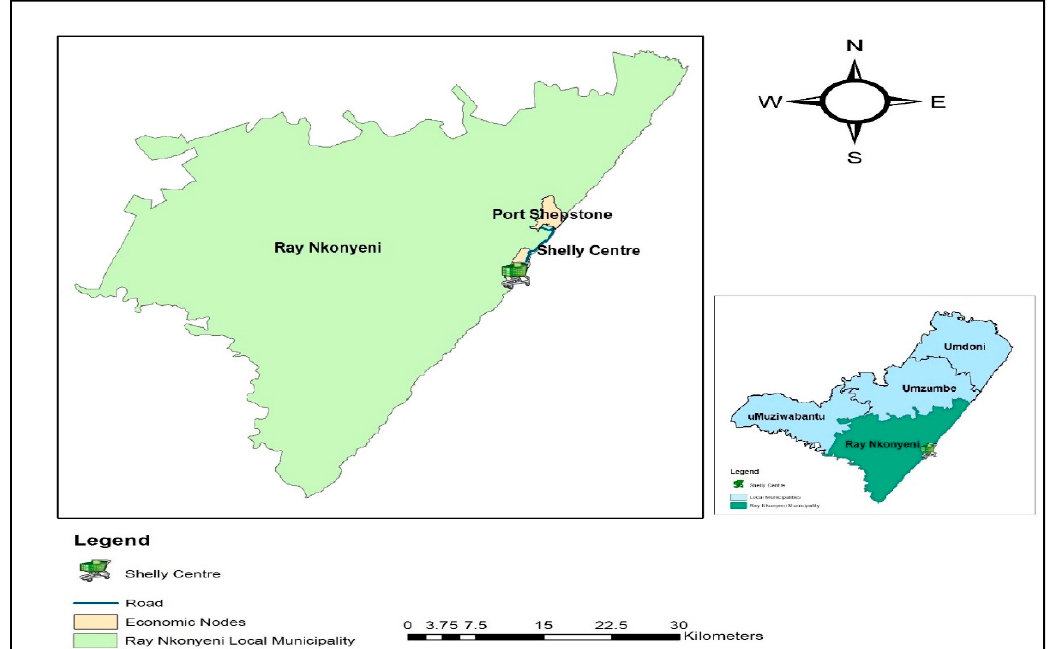
Figure 1. Map showing the location of Shelly Centre in Ray Nkonyeni Local Municipality.